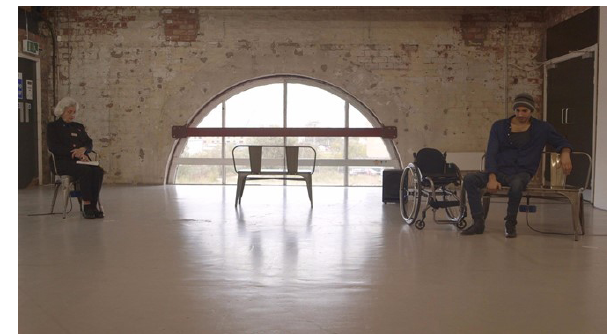
Figure 9. Finalised version of the hertz infrasound installation at Tramway, Glasgow. Two members of the public sit on furniture which have the transducers (blue) clamped underneath. The pow- erful subwoofer is in the